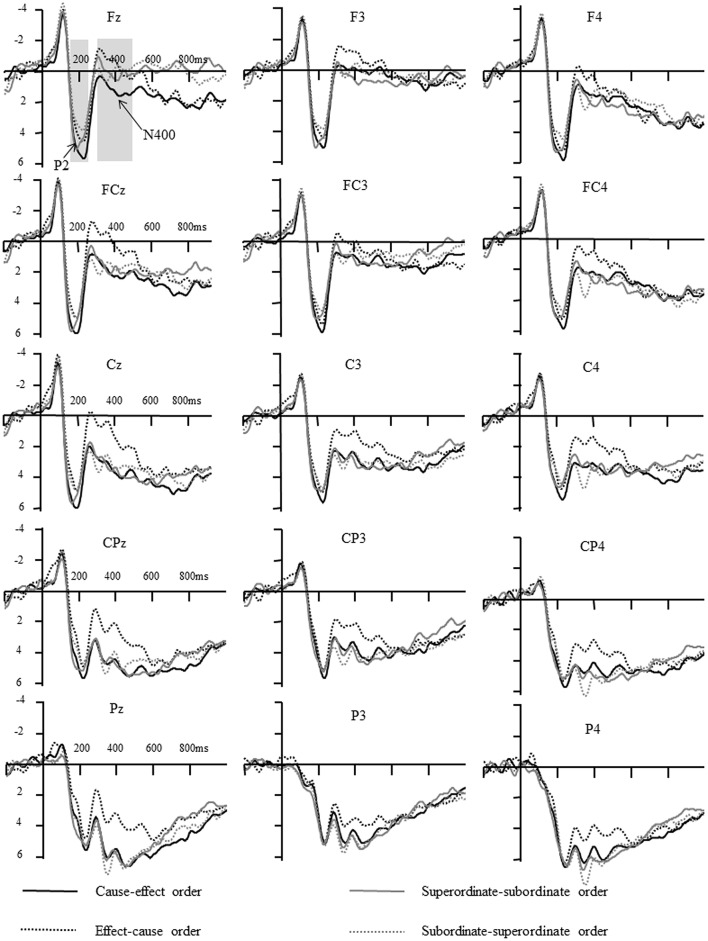
The ERPs elicited by different conditions in causal judgments and hierarchical judgments in Experiment 1.